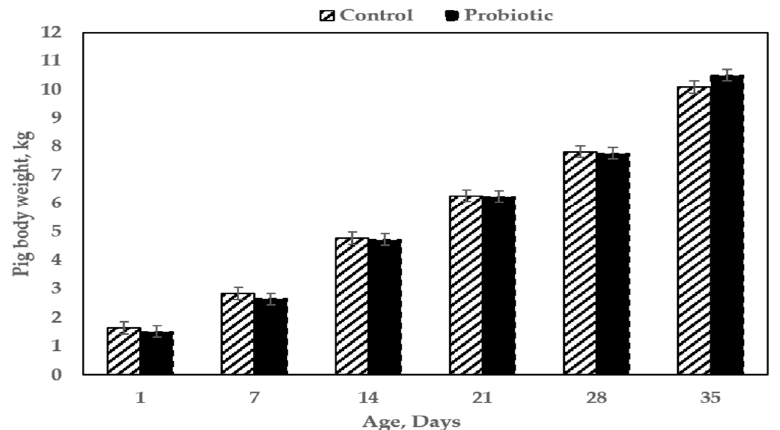
Figure 2. Body weights for pigs born to sows individually fed either control (sugar-based placebo) or probiotic ( Saccharomyces cerevisiae var. boulardii ) boluses from late-gestation through the end of lactation.